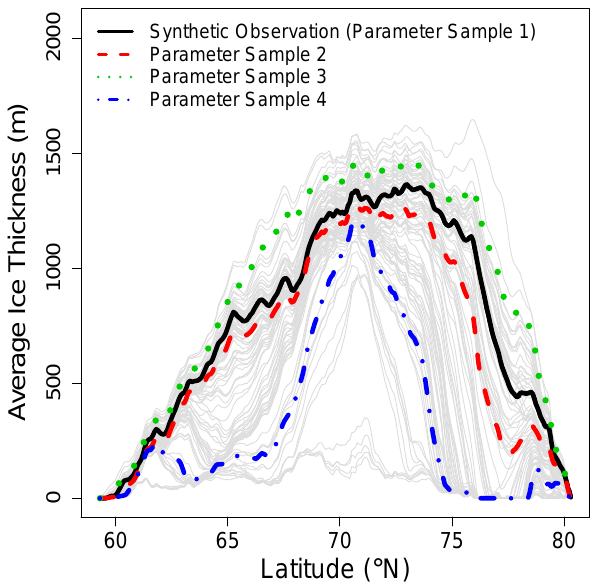
Figure 1. Profiles of zonal mean ice thicknesses from evaluations of the ice sheet model SICOPOLIS (Greve, 1997; Greve et al., 2011; Applegate et al., 2012). The solid black curve represents model run #67 from Applegate et al. (2012), which we take to be the synthetic truth for our perfect model experiments. The other curves represent examples of model runs used to construct the emulator: one run produces a zonal mean ice thickness curve similar to the synthetic observations (dashed red curve), another is generally too thick (dot- ted green curve), and a third is generally too thin (dot-dashed blue curve). As expected, our probability model assigns a greater poste- rior probability to the model run represented by the red curve than to the model runs represented by the blue and green curves. All the other model runs from Applegate et al. (2012) that are not men- tioned above are represented as grey